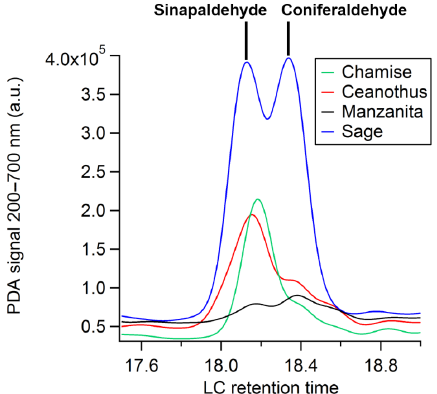
Figure 2. The lignin pyrolysis products sinapaldehyde (C 11 H 12 O 4 ) and coniferaldehyde (C 10 H 10 O 3 ) elute at slightly different reten- tion times, roughly 18.1 and 18.4min,